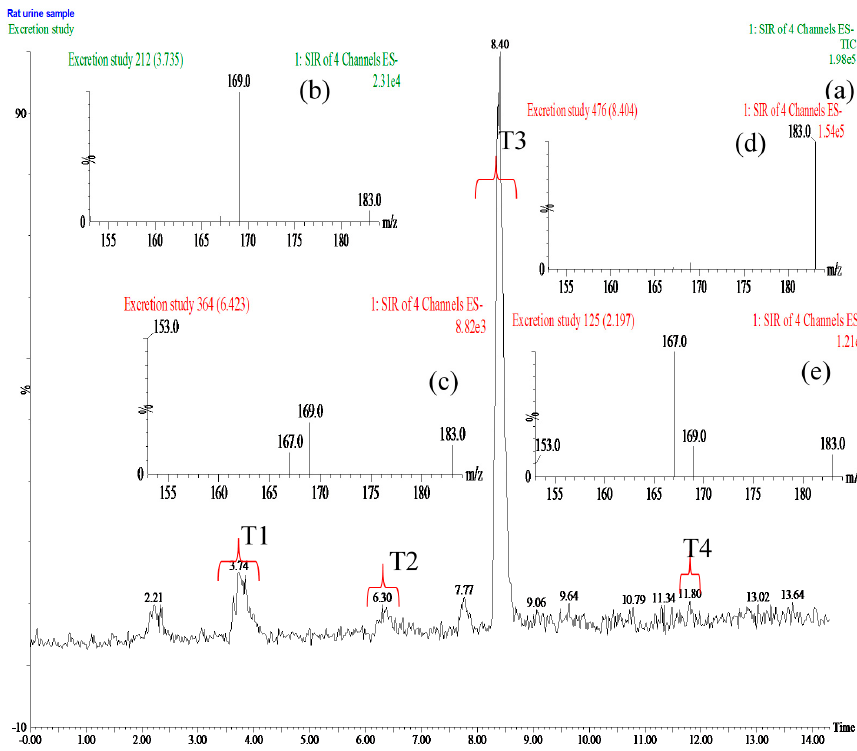
Figure 3. ( a ) Total ion chromatogram (TIC) of rat urine sample with selective ion monitoring (SIM) four ions at m/z 153, 167,169 and 183 in negative ion mode after oral administration of 60 mg/kg Polygonum capitatum extract; ( b – e ) Mass spectra of GA, PCA, 4-OMeGA and 4-OMePCA obtained from the period of T1, T2, T3 and T4, respectively.